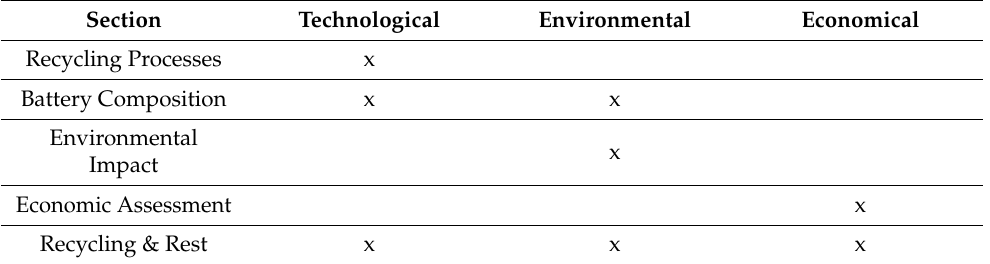
Table 2. Scope of the selected sections.